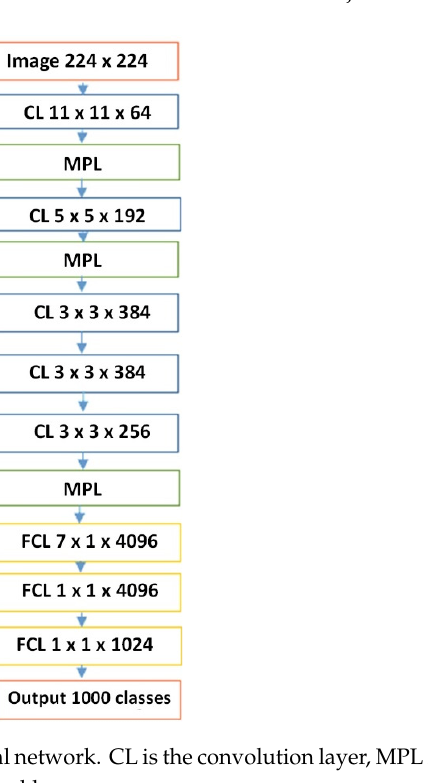
Figure 8. Architecture of the AlexNet neural network. CL is the convolution layer, MPL is the maximum pooling layer, and FCL is the fully connected layer.